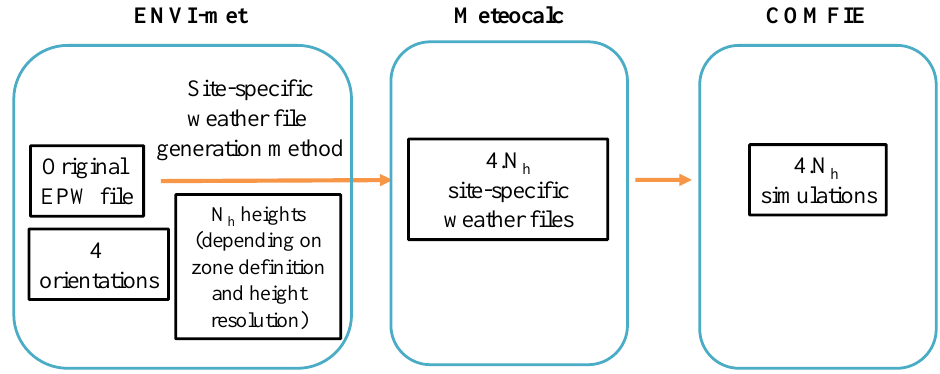
Figure 3. Method of coupling microclimate tool with the DBES tool.